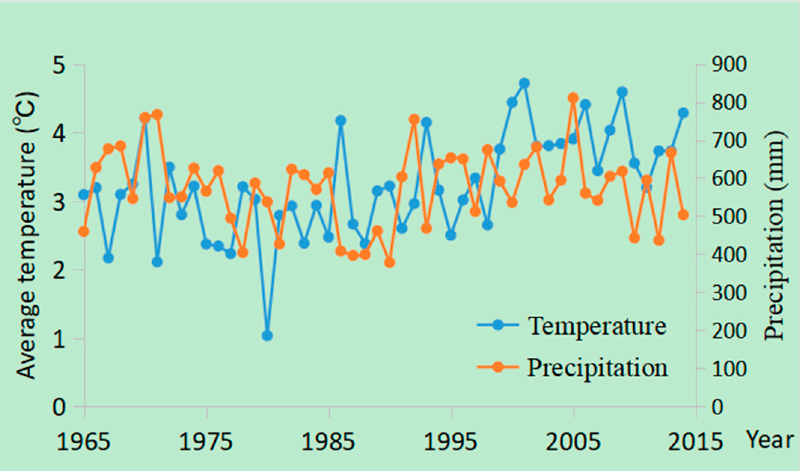
Figure 6. The temperature and precipitation changes since 1965 in the Sanjiang